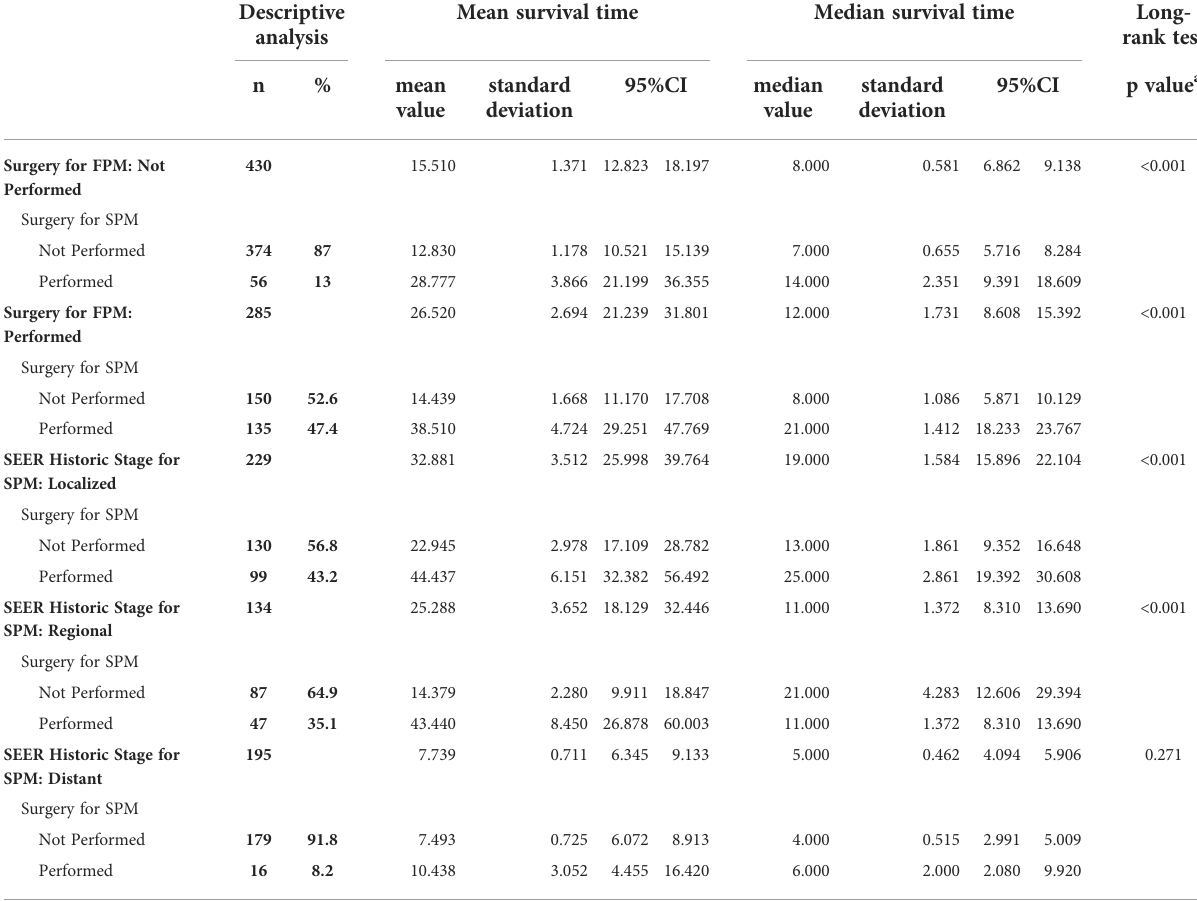
TABLE 2 Surgery for SPM Associated with Overall Survival for SPLC-EC Patients in Surgery for FPM and SEER Historic Stage for SPM of Subgroup According to the Kaplan-Meier Subsistence Analysis.